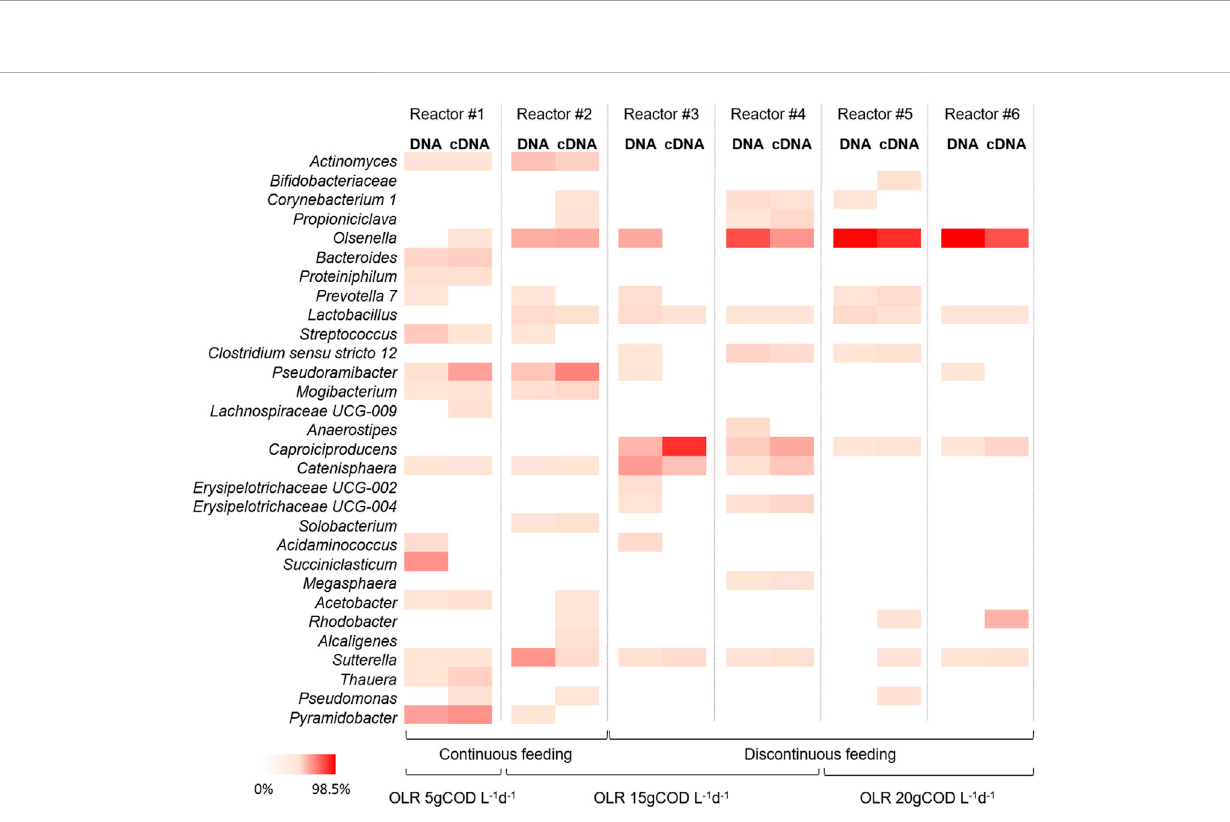
FIGURE 5 Heat-map representing the relative abundance of microbial genera ( ≥ 1% relative abundance of total reads in at least one sample) of the DNA and cDNApro fi lesofdifferentsamplestakenduringlastoperatingdayofthereactorsatdifferentOLRsandfeedingstrategies. Thecolourscalerangesfrom0 (white) to 98.5% (red) relative